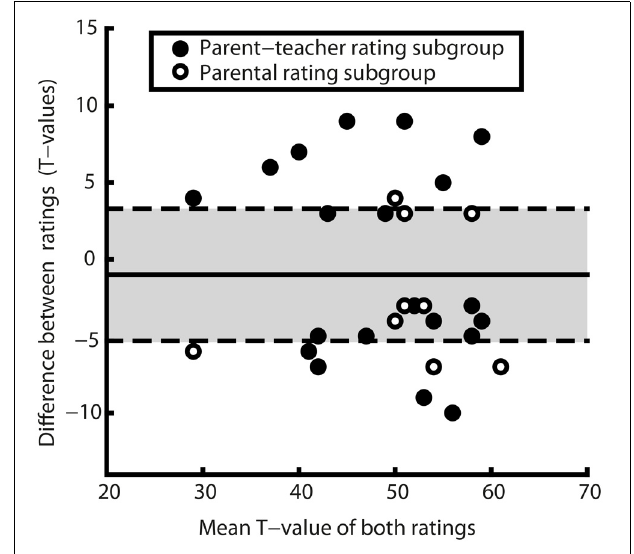
FIGURE 4 | Bland-Altman plot of T -values, corresponding to a Tukey mean-differenceplot. Thesolidlineindicatesthemeandifference( M = − 1), dashed lines mark mean difference ± 1.96SDs. Dots represent the 30 rating pairs diverging significant in the study population. Differing mother–father ratings are represented by empty, differing parent–teacher ratings by filled dots. Positive differences indicate a higher evaluation of the parent in the parent–teacher rating subgroup or a higher evaluation by the father in the parental rating subgroup ( M = − 1, SD = 5 . 7, min = − 10, max = 9). Note that all but one difference lie within in the range of ± 10 T -points (1 SD on a T -scale) and that there is no indication for systematic over- or